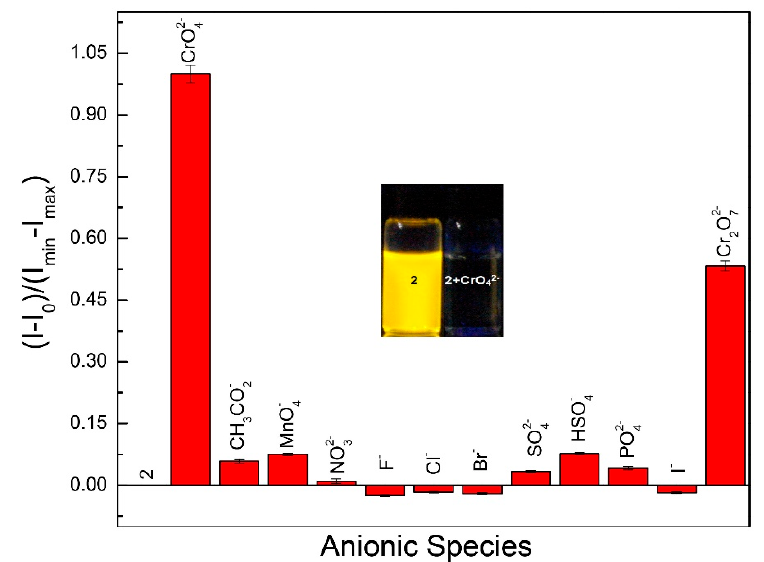
Figure 5. Quenching efficiencies of 2 (1.0 μ M) with different anions (10 equivalents) in H 2 O:DMF (9:1) containing HEPES buffer (10 mM, pH 7.4). ( λ ex = 330 nm). Inset: fluorogenic change from yellow to colorless fluorescence upon illumination at 365 nm.